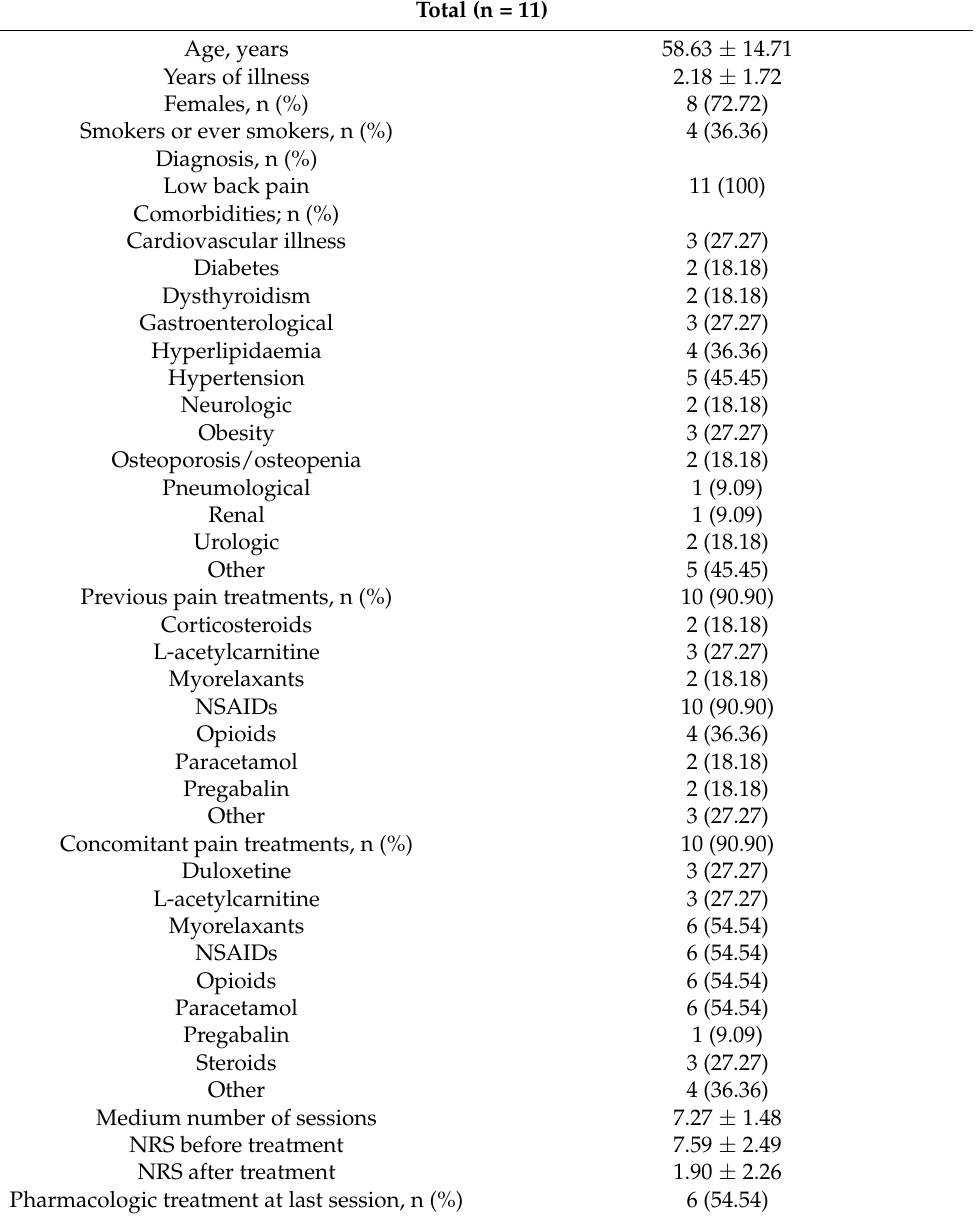
Table 5. Characteristics of the study population enrolled for topical treatment of